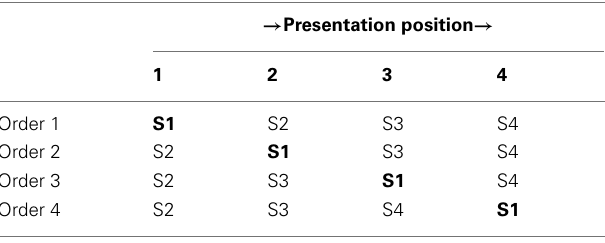
Table 2 | Symptom presentation orders used in Experiment 1.